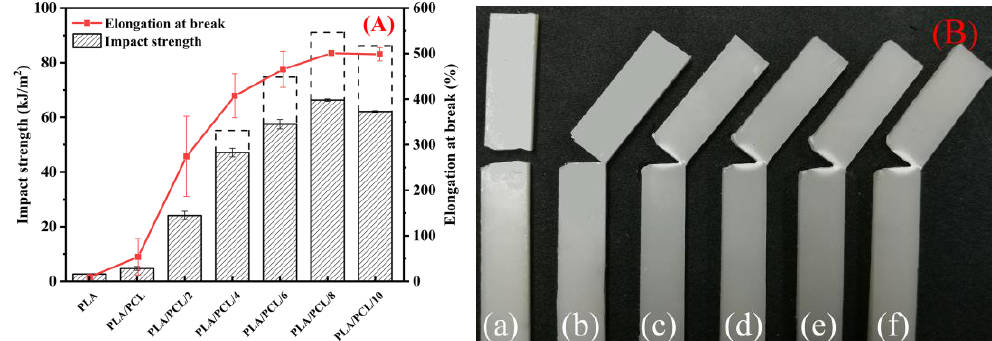
Figure 10. ( A ) Notched Izod impact strength of the neat PLA, PLA/PCL and PLA/PCL/EMA-GMA blends; and ( B ) digital pictures of the fractured samples: (a) PLA/PCL; (b) PLA/PCL/2; (c) PLA/PCL/4; (d) PLA/PCL/6; (e) PLA/PCL/8; and (f) PLA/PCL/10.